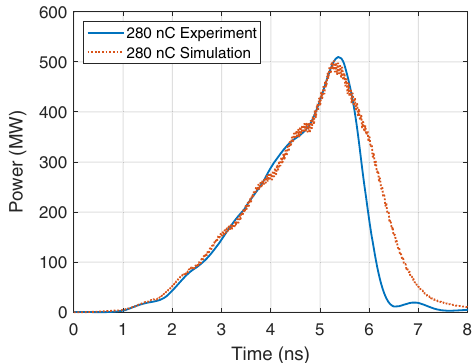
FIG. 24. Experimental trace showing 510 MW of generated output power at 11.7 GHz. The charge measured before entering the structure was 280 nC. The red simulation assumes the bunch train is offset by 0.25 mm per bunch and tilted by 0.12° per bunch.